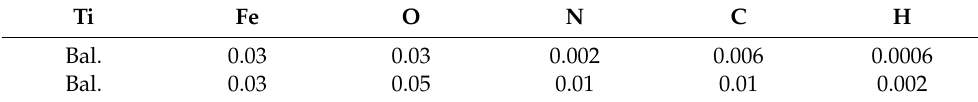
Table 1. Chemical compositions of the two pure titanium sheets used in this study (mass%). Ti Fe O N C H Ti Fe O N C H Bal. 0.03 0.03 0.002 0.006 0.0006 Bal. 0.03 0.03 0.002 0.006 0.0006 Bal. 0.03 0.05 0.01 0.01 0.002 Bal. 0.03 0.05 0.01 0.01 0.002